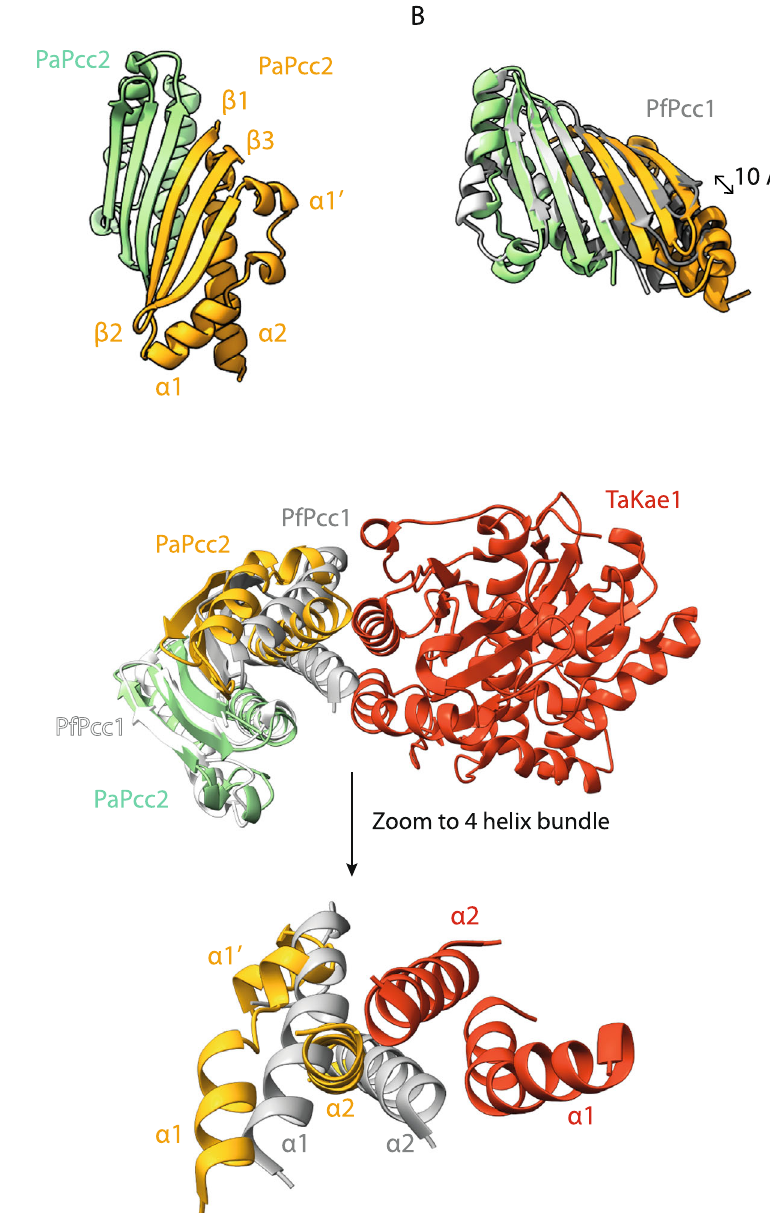
Fig. 4 | Crystal structure of PaPcc2 homodimer. A The subunits are in green and yellow, the third copy in the asymmetric unit is not shown. The β 1 strands of the greenandtheorangecopiesassociateinantiparalleltocreateacontinuous β -sheet. Thethirdcopy(gray)islooselyassociatedwiththeorangecopyandthisinterfaceis probably purely crystallographic. This copy forms with a crystal symmetry related mate the same type of dimer as the green/orange. B Superposition of the PaPcc2